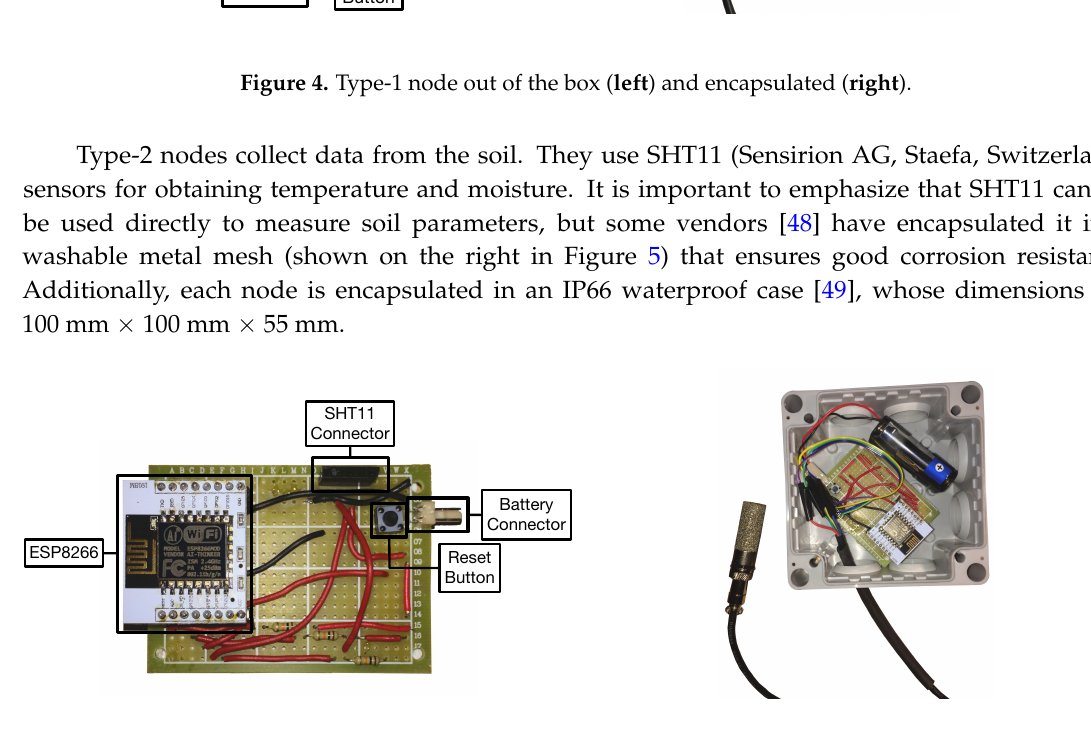
Figure 5. Type-2 node out of the box ( left ) and encapsulated ( right